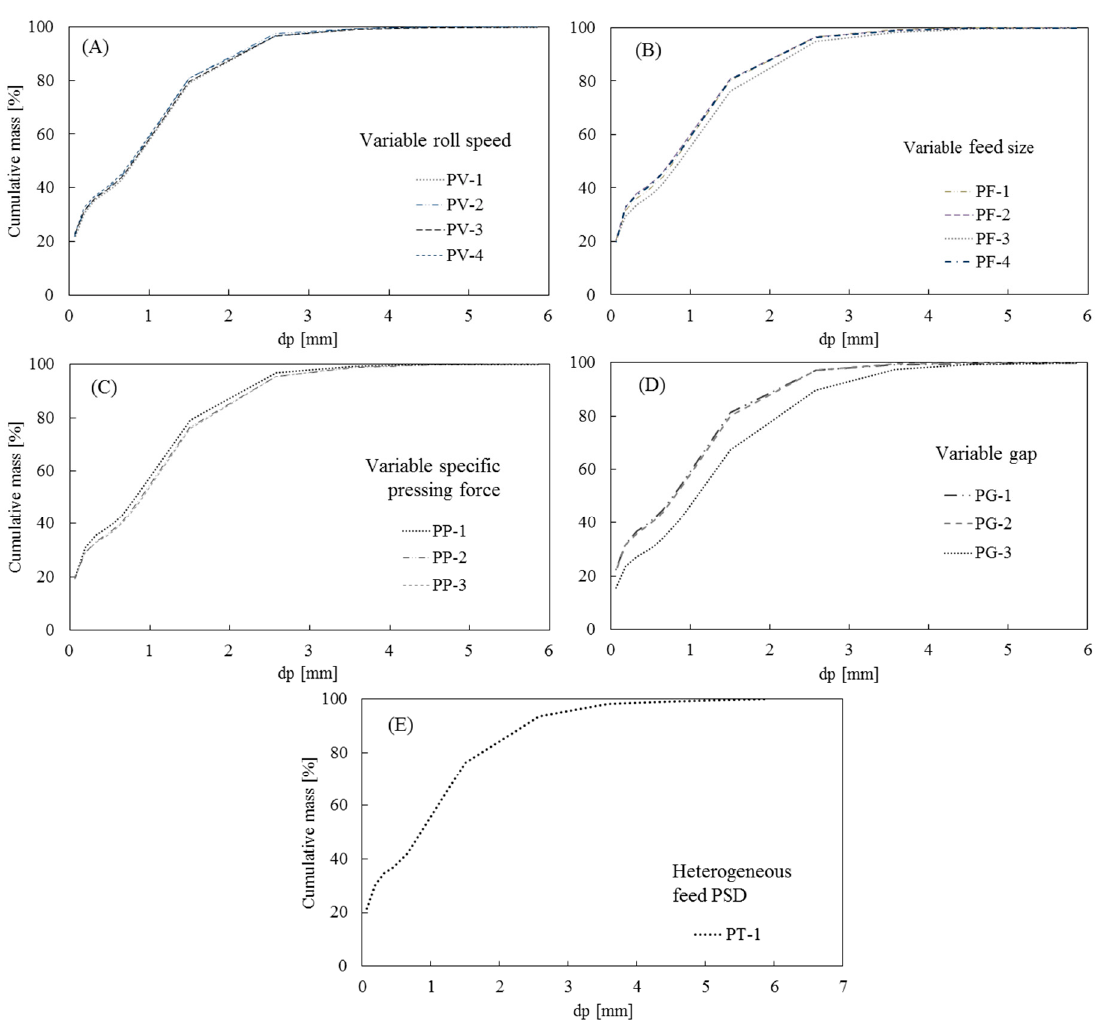
Figure 8. Product particle size distribution for experiments using the calc-silicate material. ( A ) Experiments MV-1 toMV-4, showing the effect of varying roll speed; ( B ) experiments MP-1 to MP-5, changing the specific pressing force and ( C ) experiment MT-1, performed with a heterogeneous feed particle size distribution.